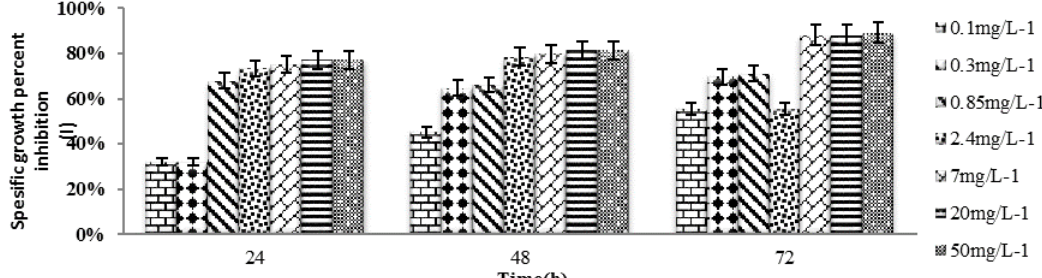
Fig. 2. Doubling time Growth Rate (G) of Dunaliella salina during the Experiment at different concentrations of SiO 2 NPs